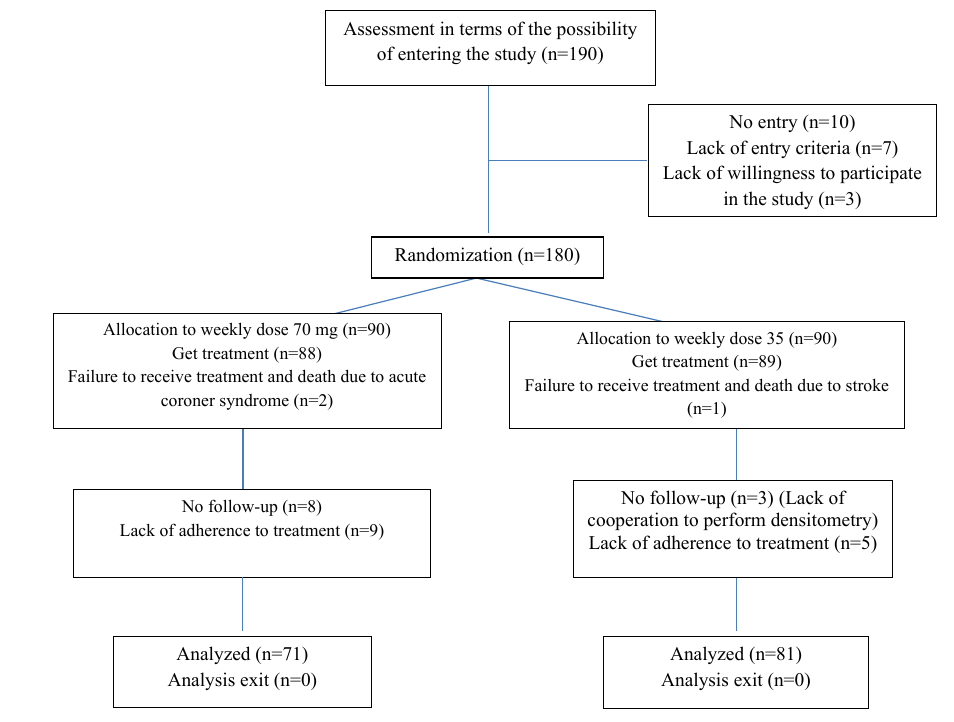
Figure 1. Flow chart of enrollment and allocation of participants and study design